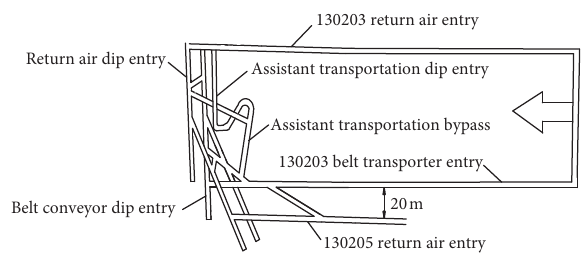
Figure 1: 130203 fully mechanized working face layout